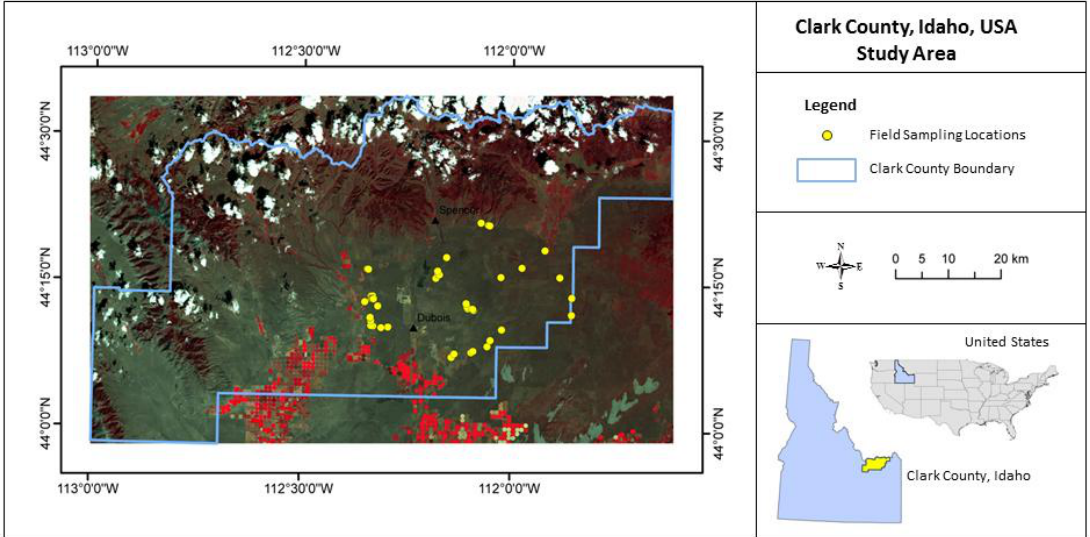
Figure 1. The basalt mapping study area and field sampling locations in Clark County, ID, USA.